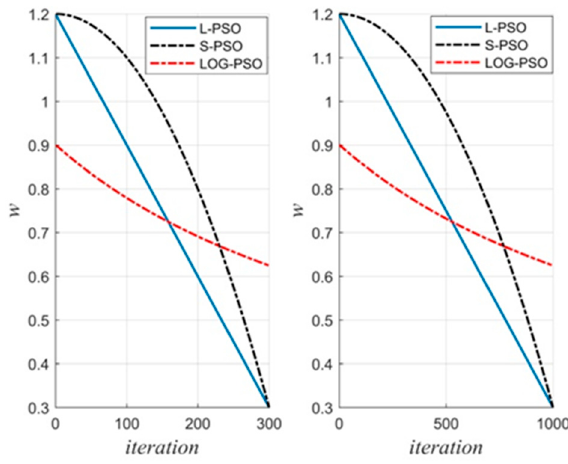
Figure 1. Inertial weight profile with respect to iterations.